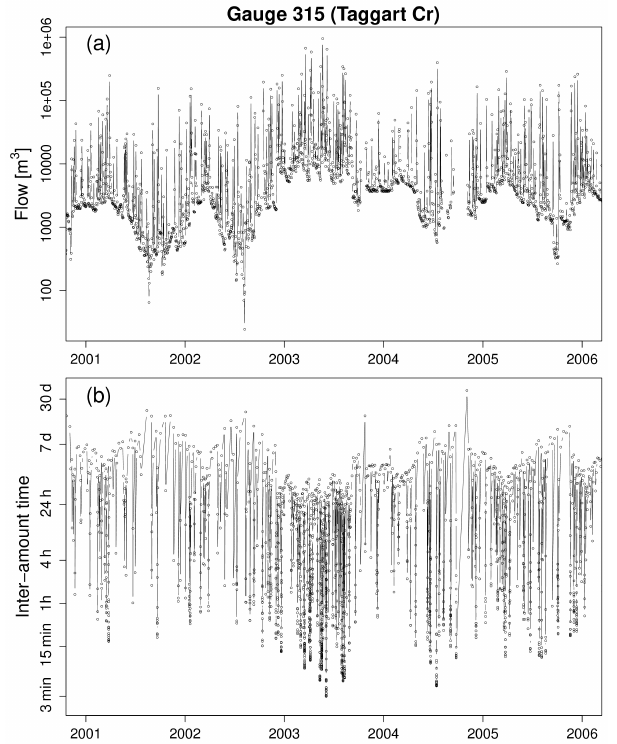
Figure 2. Example of times series for flow (a) and for associ- ated inter-amount times (b) for the flow gauge at Taggart Creek, a 13.6km 2 basin in the Charlotte catchment.